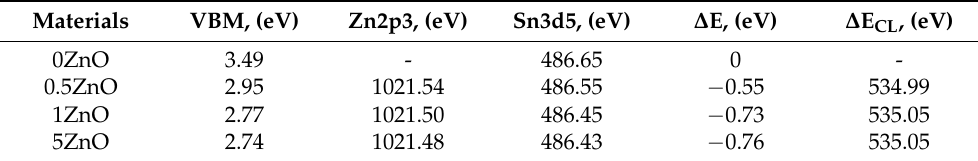
Table 3. Valence band edge values and binding energy of core levels.